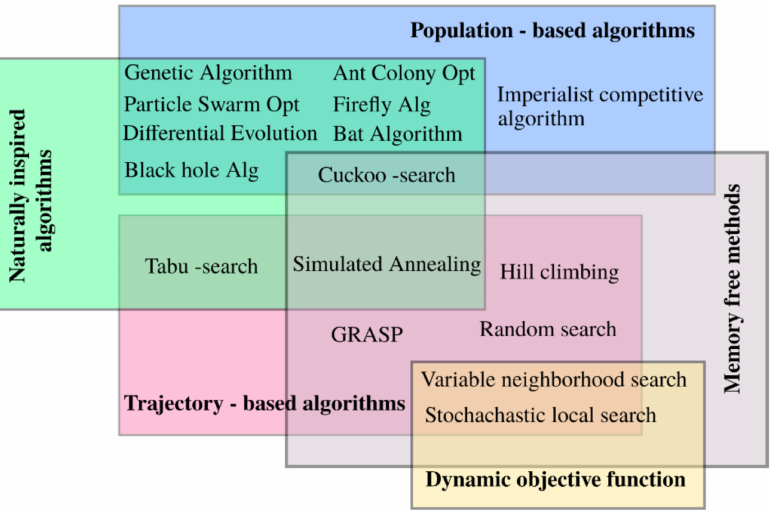
Figure 2. Metaheuristic methods and their categorization (reprinted from Ref.